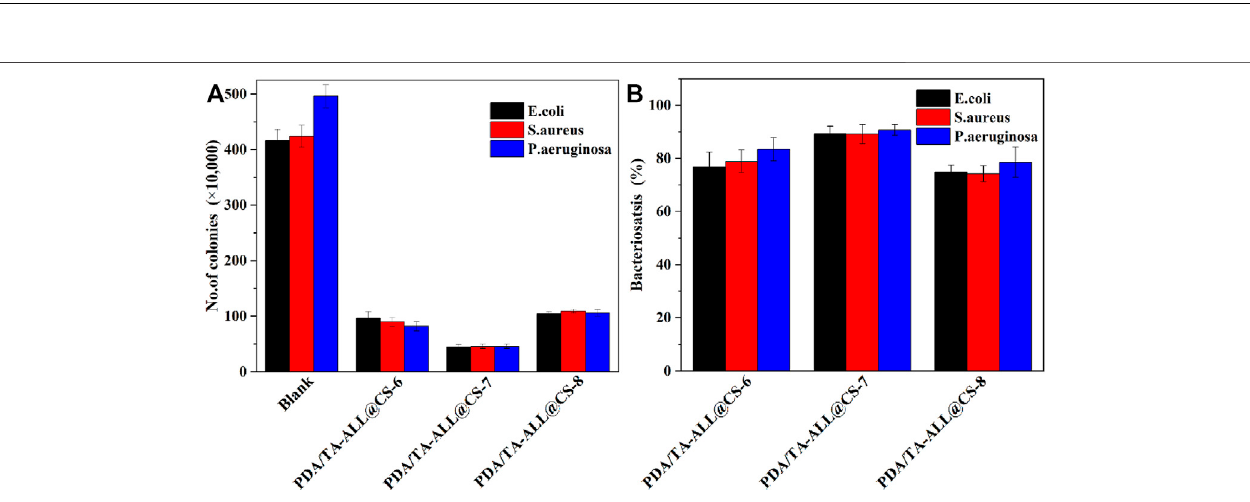
FIGURE 8 | Number of E. coli , S. aureus , and P. aeruginosa bacterial colonies on the solid medium after incubation with the controlled specimen and prepared coatings inLuria-Bertani mediumfor18 h (A) ;thebacteriostasis of E.coli , S.aureus ,and P.aeruginosa forthePDA/TA-ALL@CS-ncoatings (B) .ForPDA/TA-ALL@CS- 6, PDA/TA-ALL@CS-7, and PDA/TA-ALL@CS-8 coatings, the volume ratios of TA solution to ALL@CS suspension were about 6:4, 7:3, and 8:2, respectively.